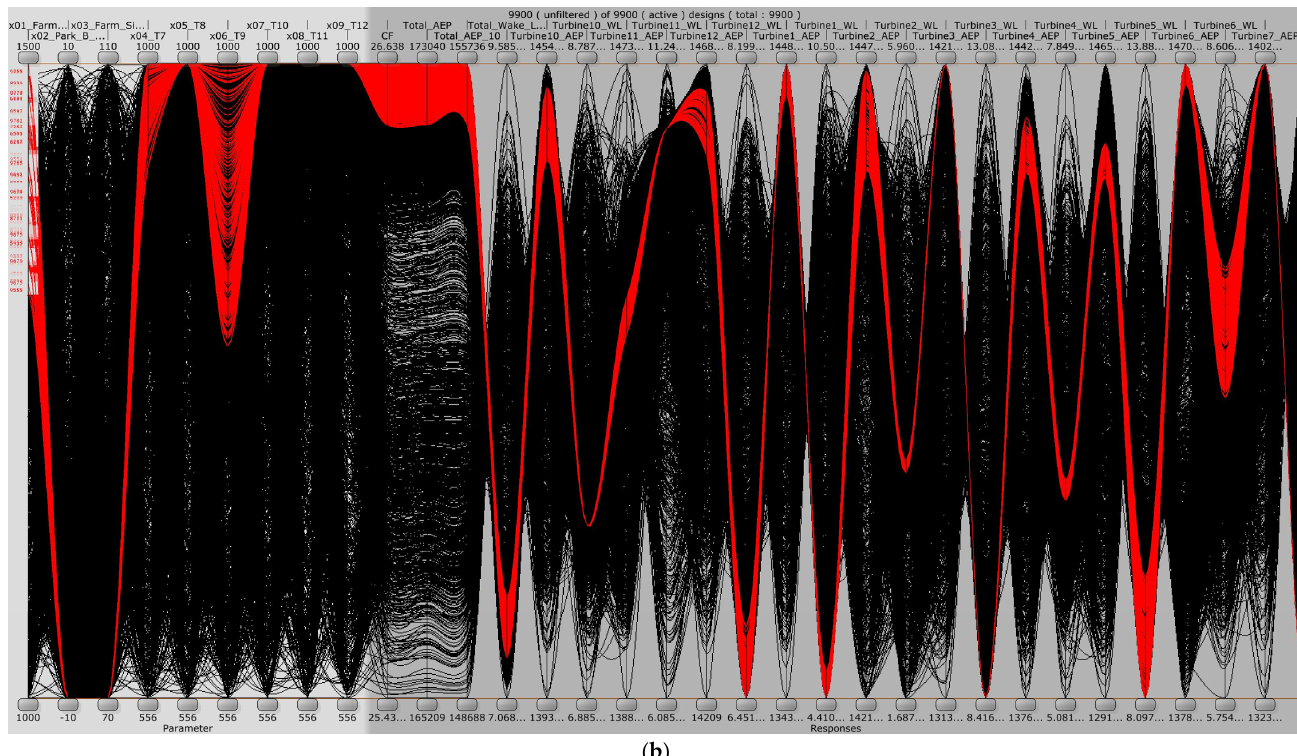
Figure 7. Optimal solutions achieved through ( a ) evolutionary algorithm (EA) and ( b ) particle swarm optimization (PSO) algorithm.